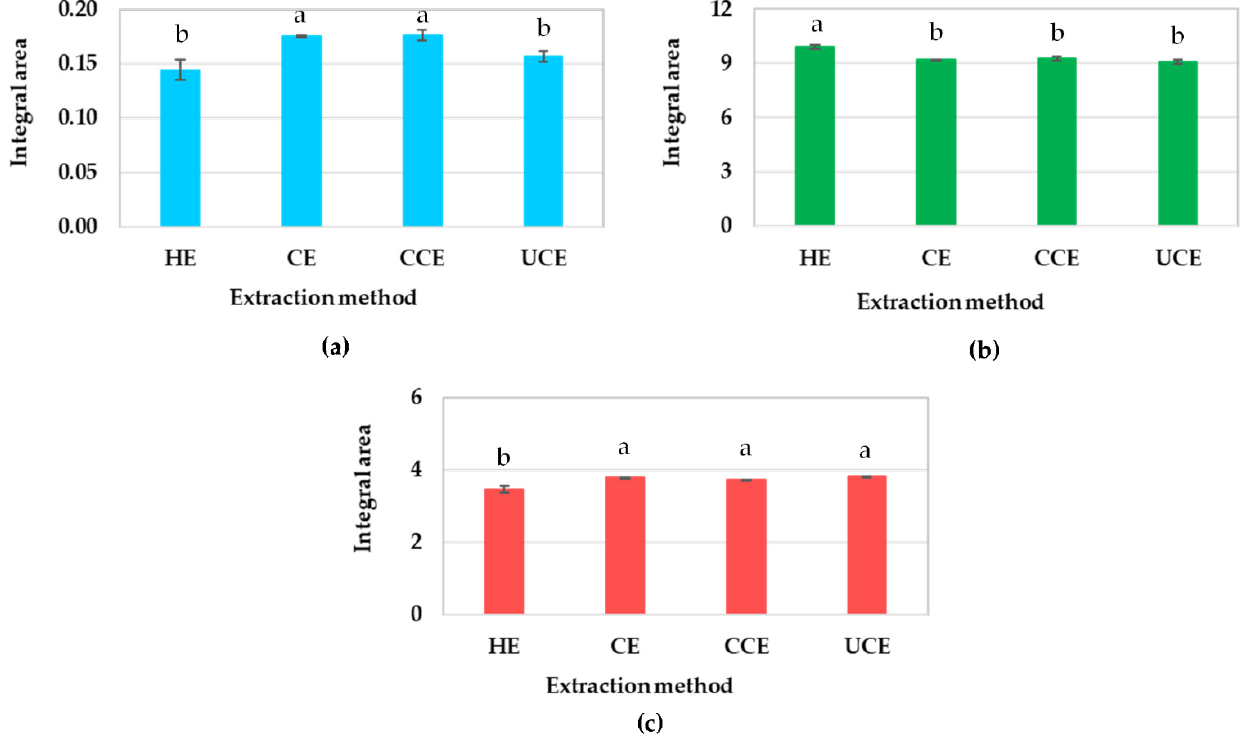
Figure 6. The integral areas of absorption peaks at: ( a ) 3008 cm −1 ; ( b ) 2918–2850 cm −1 ; ( c ) 1743–1711 cm −1 . HE: hexane extraction, CE: cold press extraction, CCE: cooking process combined with cold press extraction, UCE: ultrasonic pretreatment combined with cold press extraction. The values are the mean of three replications ± standard deviation. Different superscripts on bars indicate statistical differences between extraction methods ( p < 0.05).